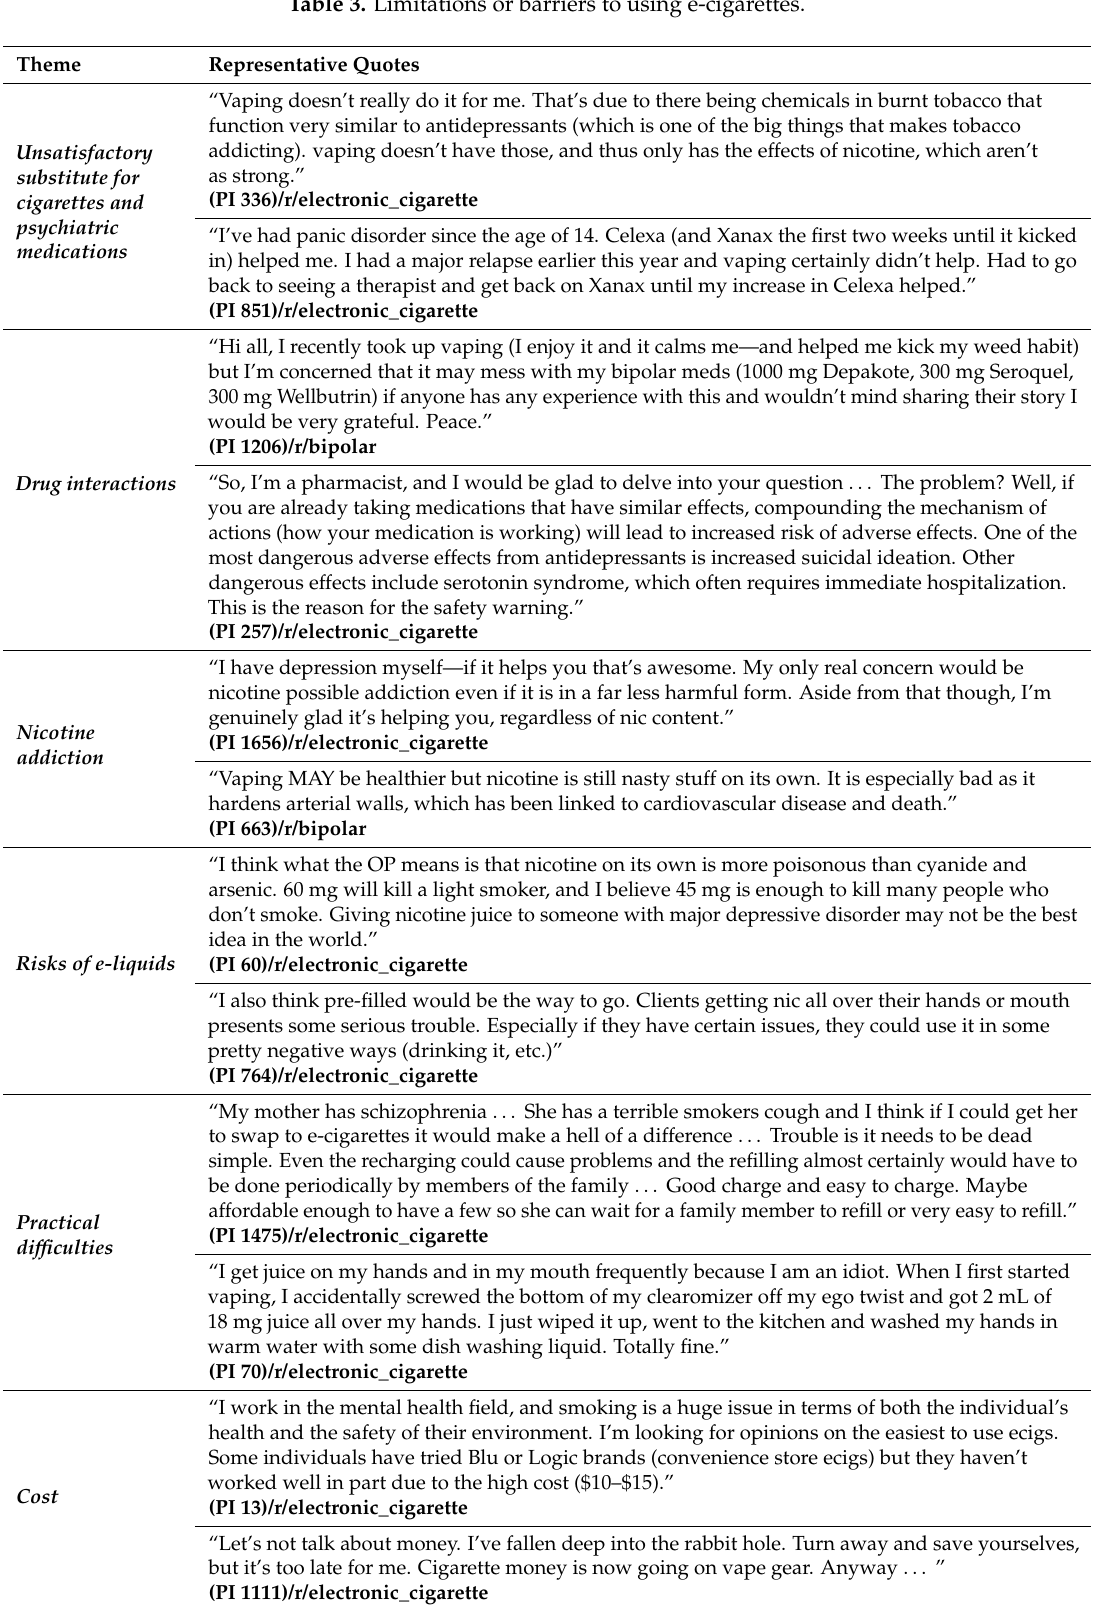
Table 3. Limitations or barriers to using